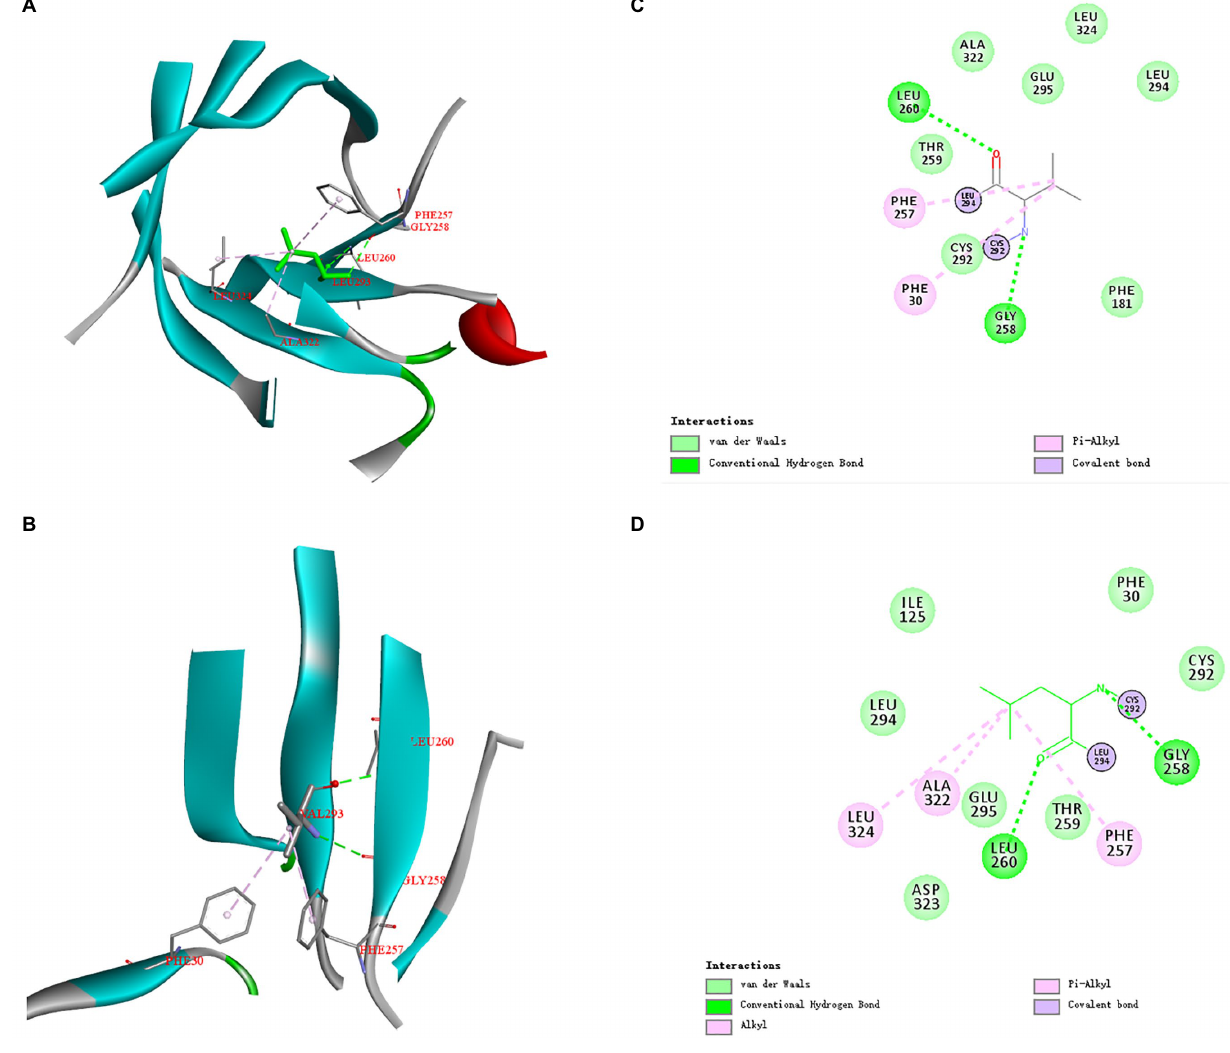
FIGURE 6 | Overall structure and modeled complex structures of ManAK (A) and ManAK L293V (B) in position 293. The amino acid residues around position 293 are indicated in red. The interactions between them are represented by a dashed line. Interaction analysis of amino acid site ManAK (C) and ManAK L293V (D) . The green dashed line indicates Conventional Hydrogen Bond interaction; the pink dashed line indicates Alkyl and Pi-Alkyl interaction. Amino acid residues that form van der Waals interactions with amino acid in position 293 are indicated in light green balls and Covalent bond are indicated in